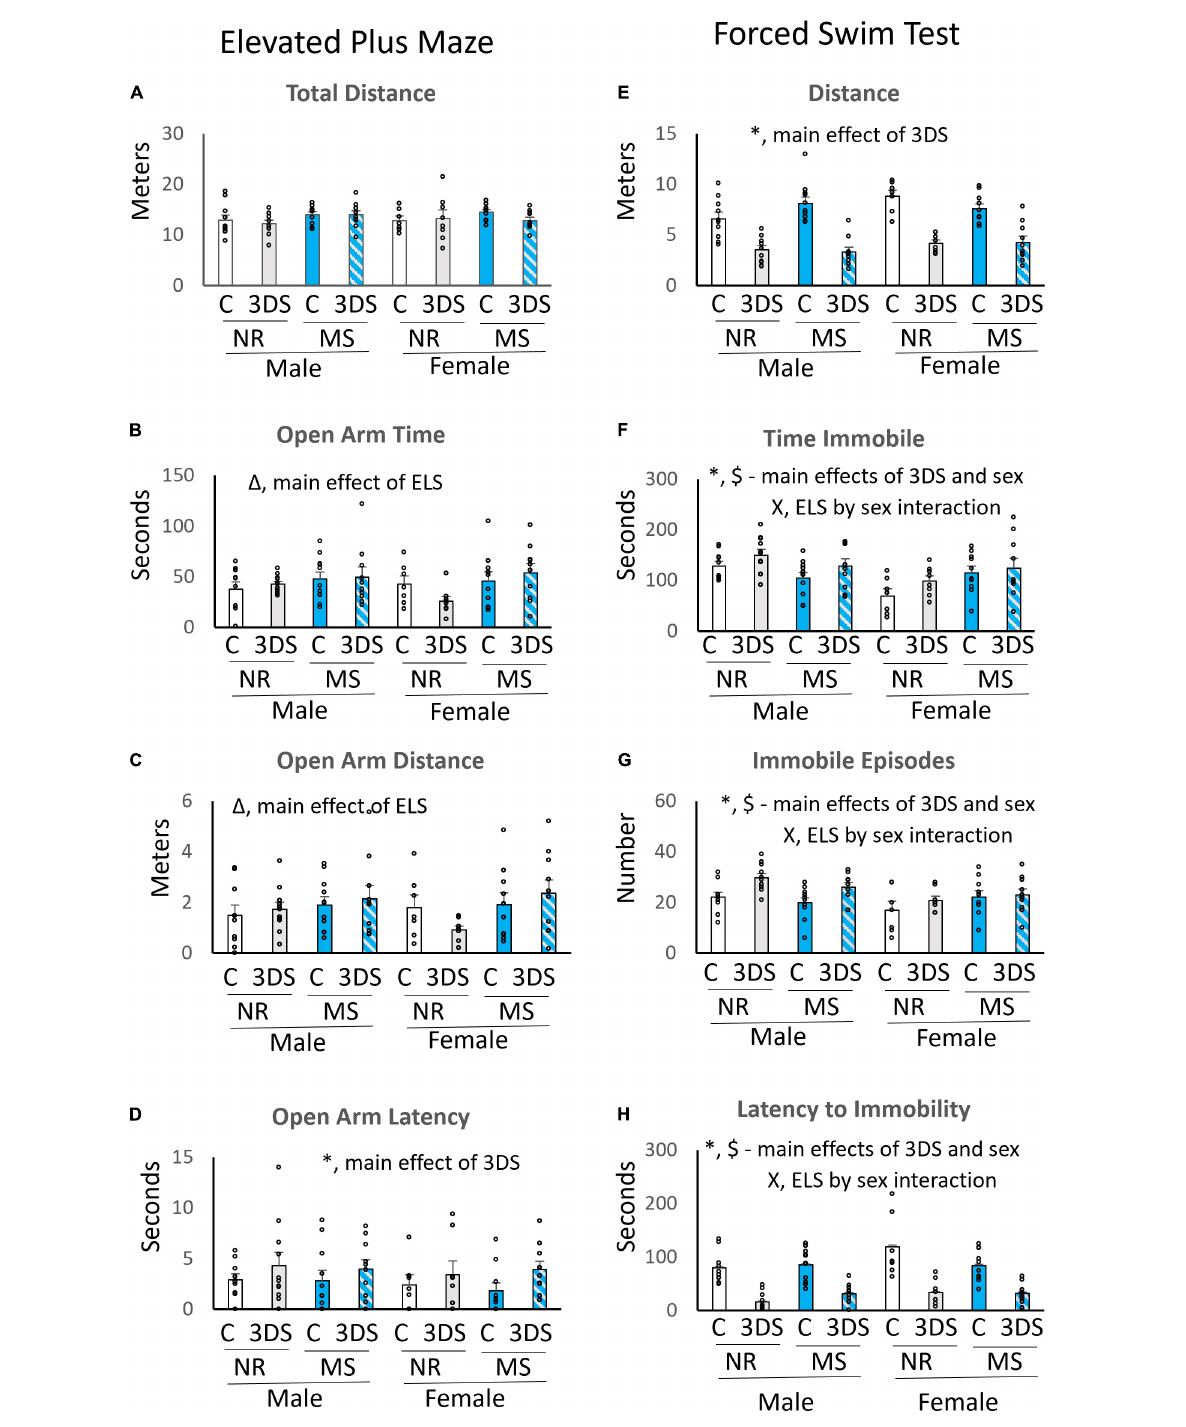
FIGURE3 The effects of maternal separation and 3 days of variable stress on behavior in the elevated plus maze and forced swim test. For the elevated plus maze the average total distance traveled (A) , time spent in the open arms (B) , distance traveled in the open arms (C) , and latency until the first entry into an open arm (D) are plotted. For the forced swim test the average total distance traveled (E) , time spent immobile (F) , number of immobile episodes (G) , and latency until the first immobile episode (H) are plotted. Error bars reflect the standard error of the mean. Each individual data point is shown. NR, stands for normal rearing; MS, stands for maternal separation; C, stands for control; and 3DS stands for 3 days of stress exposure. N = 10 for male NR control, 11 for male NR 3DS, 11 for male MS control, 10 for male MS 3DS, 7 for female NR control, 8 for female NR 3DS, 10 for female MS control, and 10 for female MS 3DS. ∗ Denotes a main effect of adult stress, (cid:49) denotes a main effect of early life stress, $ denotes a main effect of sex, and X denotes an early life stress by sex interaction by three-way